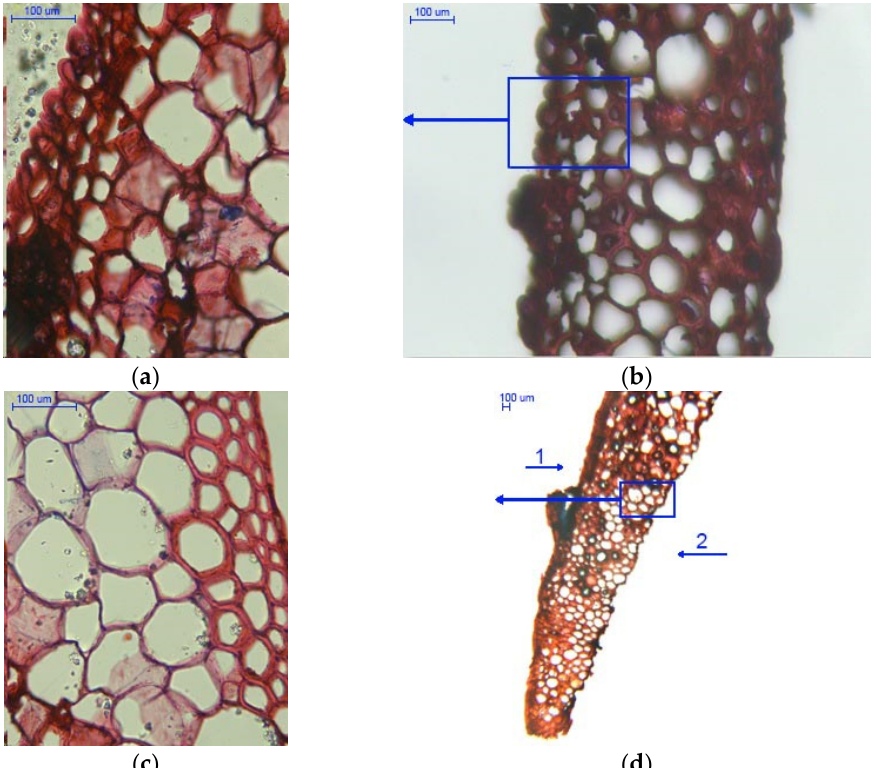
Figure 6. Cross-sections of scales with a moisture content of 5%: ( a ) outer epidermal cell layer (400×); ( b ) scale with visible cell layers (100×); ( c ) scale with visible cell layers on the inner side (400×); and ( d ) scale with visible cell layers in the marginal region (40×), 1—outer side of the scale, and 2—inner side of the scale.